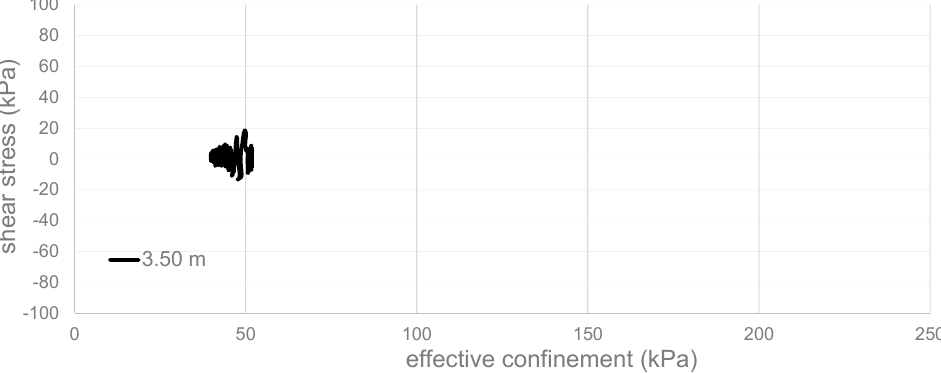
Figure 8. Model-10 m: effective confinement vs. shear stress at 3.50 m depth.